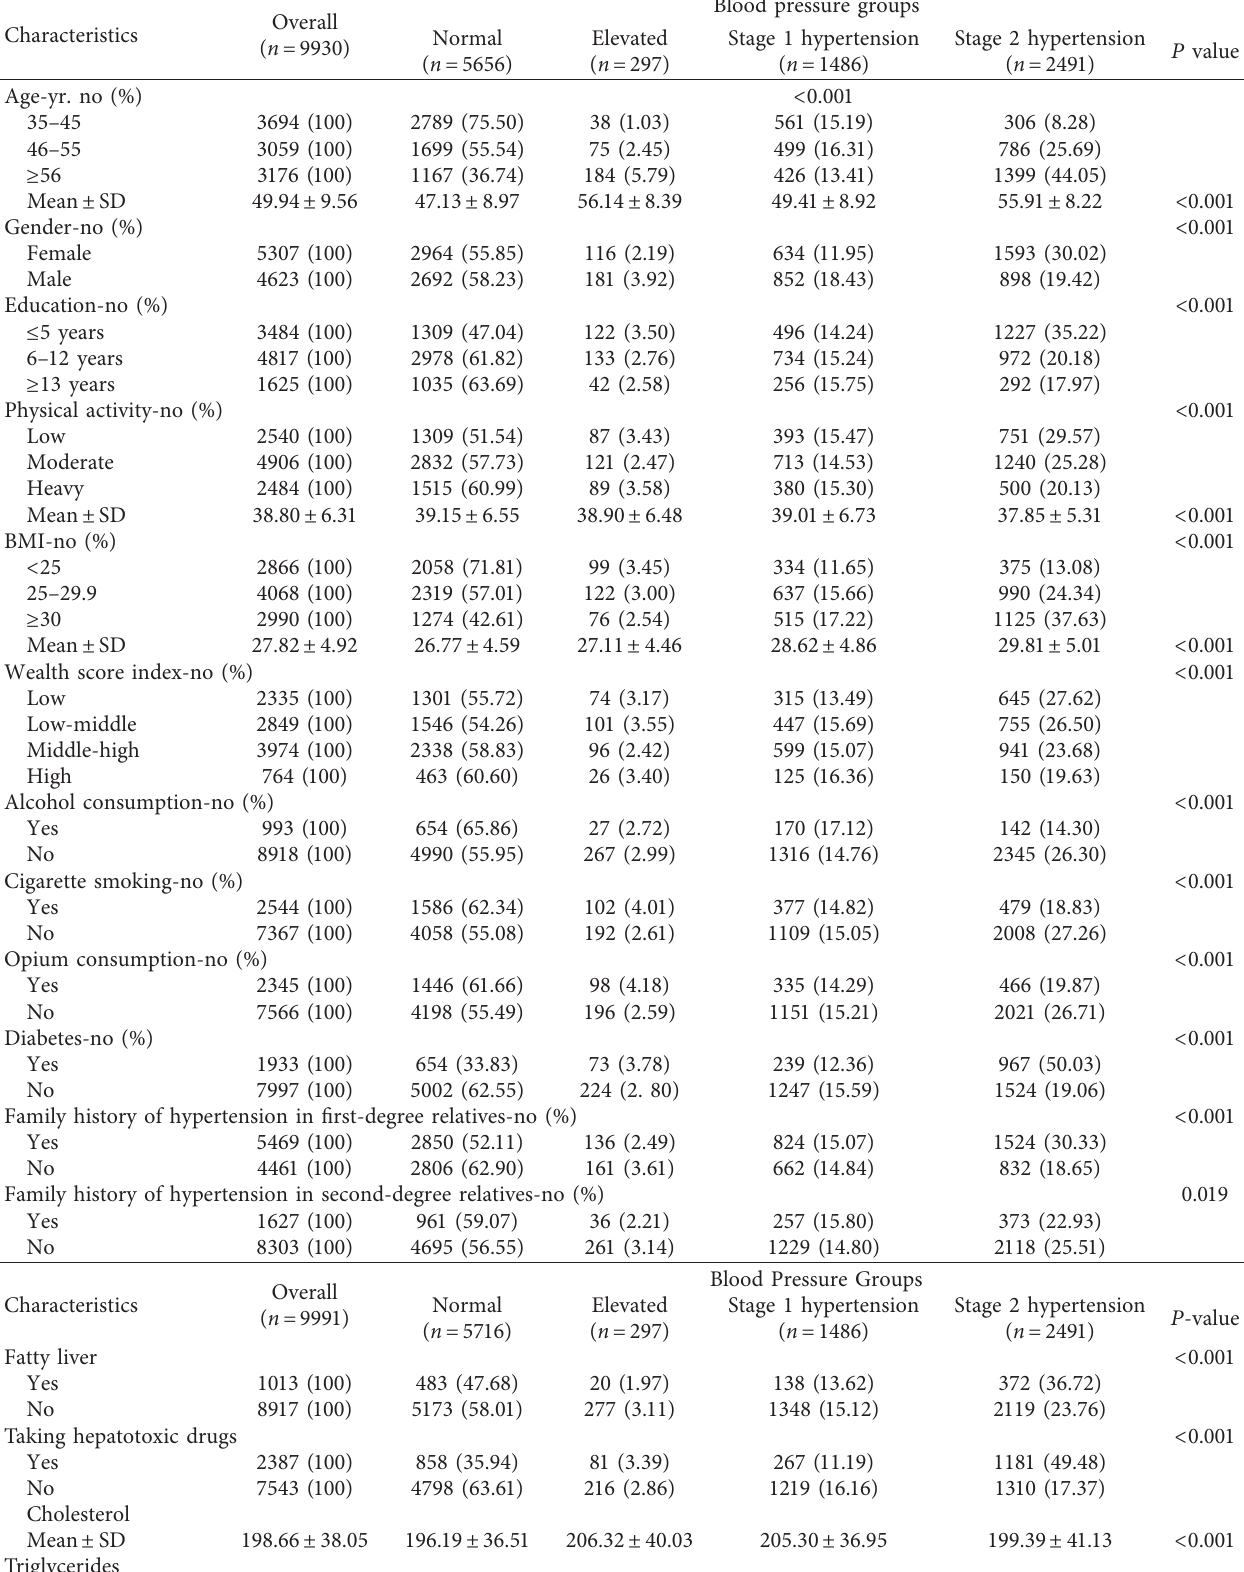
Table 1: Demographic, selected medical and laboratory characteristics of study participants by blood pressure groups ( n �